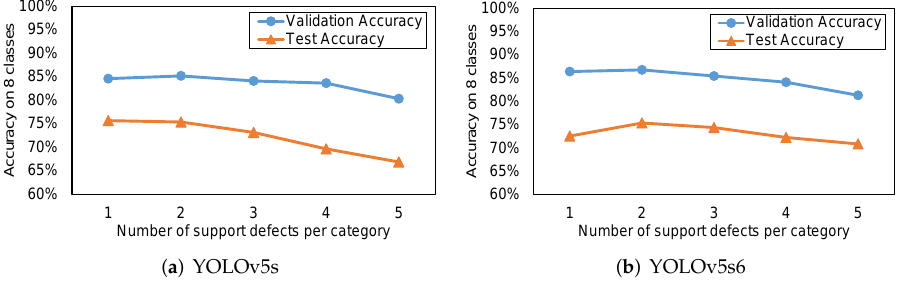
Figure 8. Effect of different number of support defects per category on validation and test perfor- mance of ( a ) YOLOv5s with FA and ( b ) YOLOv5s6 with